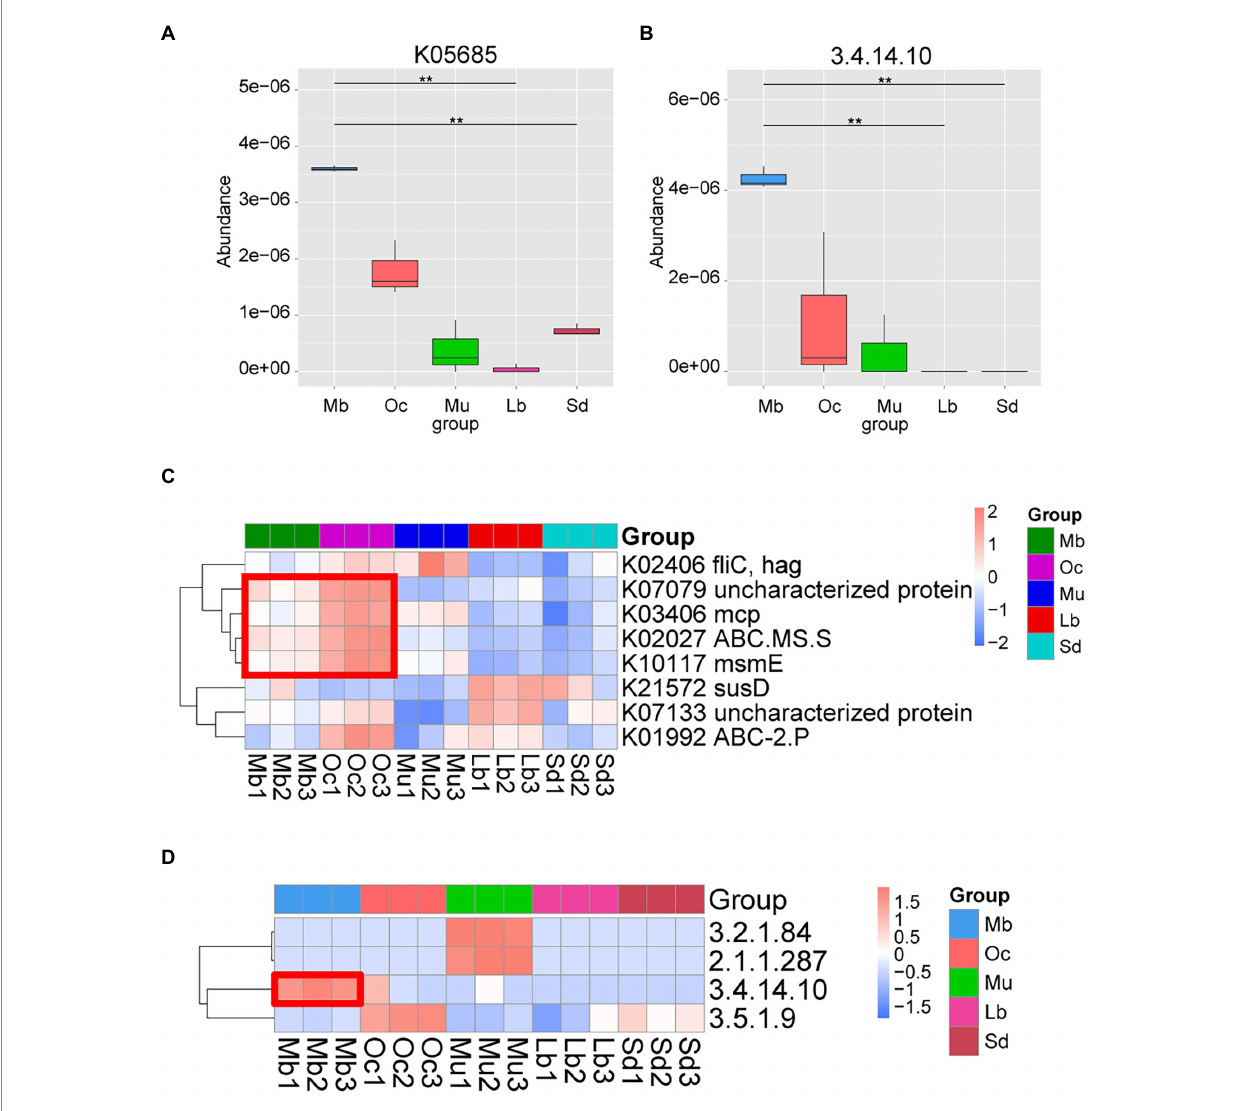
FIGURE 4 Functional metagenomic comparison of the gut microbiota in different groups. (A) KO terms with significant differences between groups. The horizontal axis is the group name and the vertical axis is the relative abundance of the corresponding species. Pairwise statistical analysis was done by Metastats. * and ** denote q -value < 0.05 and q -value<0.01, respectively. (B) EC Number with significant differences between groups according to the results of Pairwise statistical analysis by Metastats. (C) Heatmap of KEGG ortholog pathways showing different enrichments according to the results of LEfSe differential